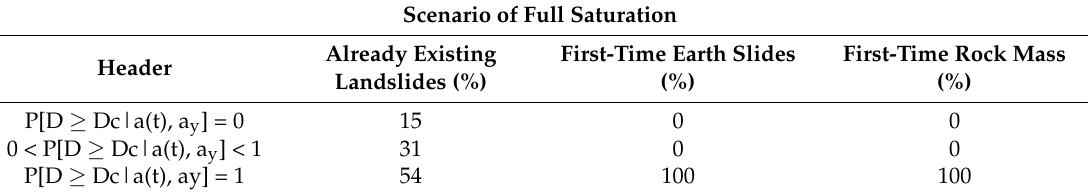
Table 8. Results obtained in terms of exceedance probability for the full saturation scenario (RT = 475 years).